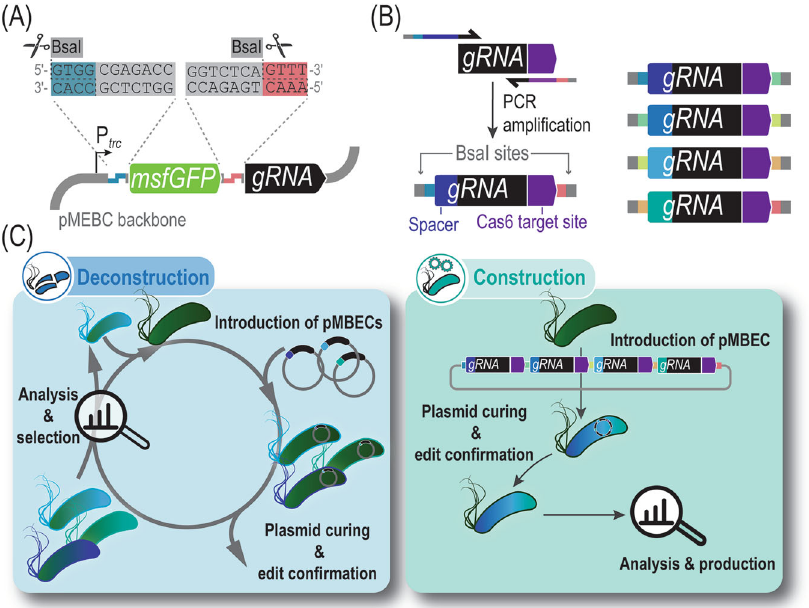
Fig. 4 Work fl ow for base editing-mediated (de)construction of complex bacterial phenotypes. A To facilitate cloning procedures, a fl uorescent protein marker was added to the pMBEC backbone, facilitating rapid counterselection of template vectors. The base editing-plasmid contains a constitutively- expressed msfGFP module fl anked by BsaI recognition sites. This marker is replaced by either one spacer sequence or multiple gRNAs through Golden Gate assembly. B Generation of gRNAs through PCR for multiplexed genome editing. The Cas9 handle is ampli fi ed along with a Cas6 recognition sequence from a template vector, while the speci fi c spacer sequence and Golden Gate- fl anking motifs are introduced in the oligonucleotide sequences. The resulting gRNAs harbor unique BsaI sites that can be used to compose multiplex arrays by Golden Gate cloning. C pMBECs vectors enable deconstruction and construction of complex phenotypes by multiple genome editing. SacB-mediated curing of these plasmids facilitates multiple editing cycles upon con fi rmation and analysis of the resulting bacterial